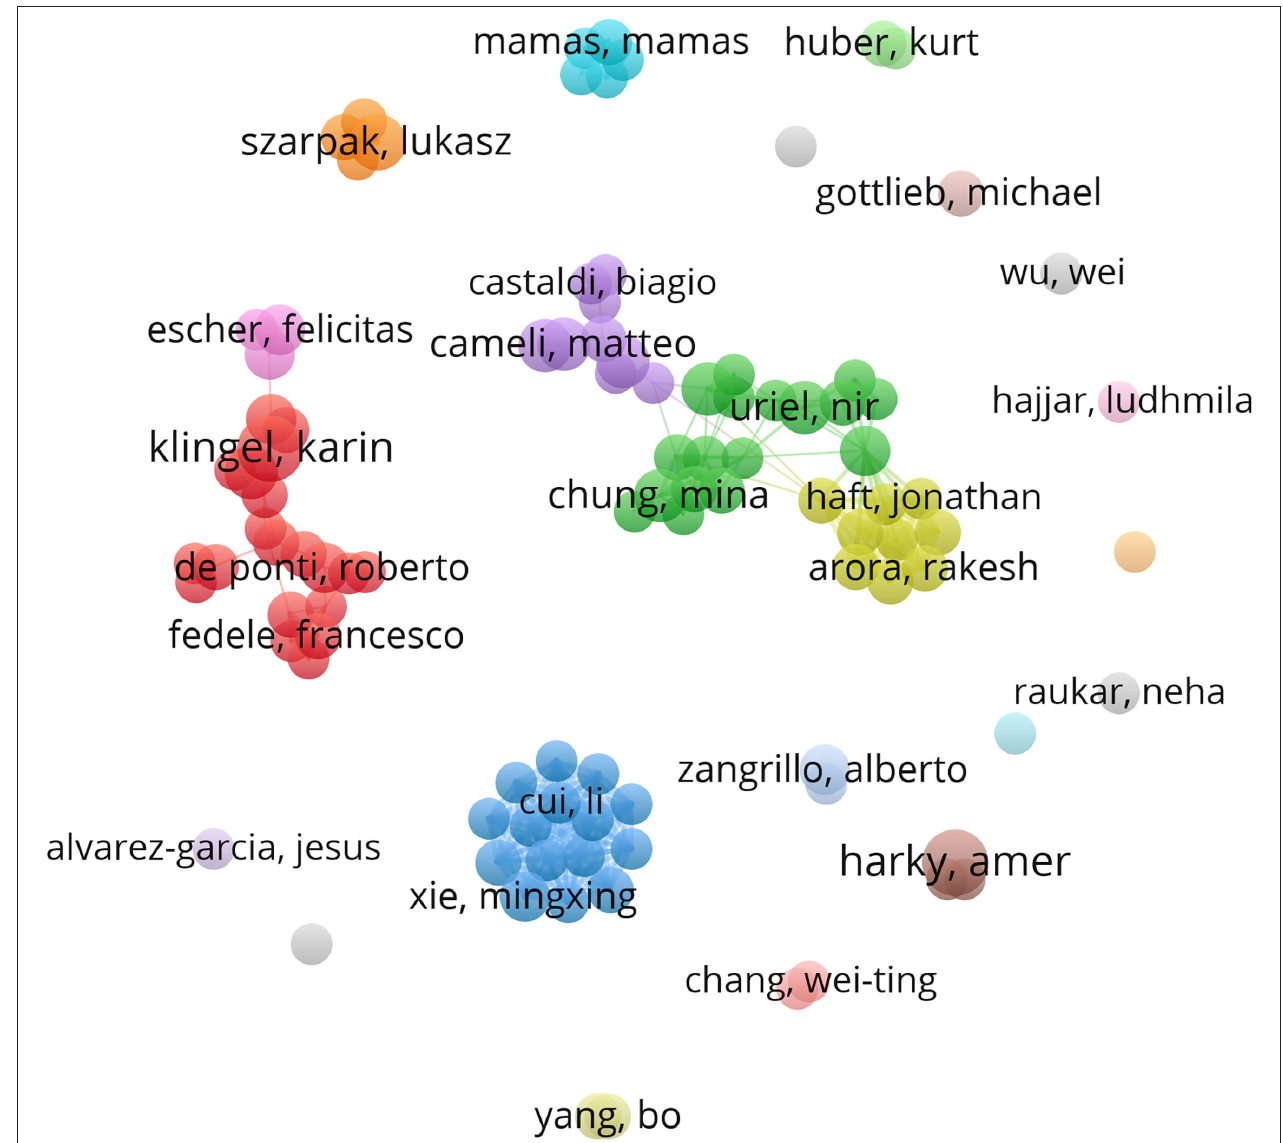
FIGURE 5 | The detailed information of the authors’ distribution. Each node represented an author, with larger nodes representing more published articles. Different colors referred to clusters of close cooperation. Karin Klingel and Amer Harky had the greatest number of published papers. Most authors were scattered and lacked stable and intensive cooperation and communication. Some authors mainly cooperated on a small scale in this research area. Karin Klingel only cooperated with DaoWen Wang, Enrico Ammirati, Burkert M. Pieske, and Carsten Tschoepe. Amer Harky only cooperated with Aung Oo and Ana